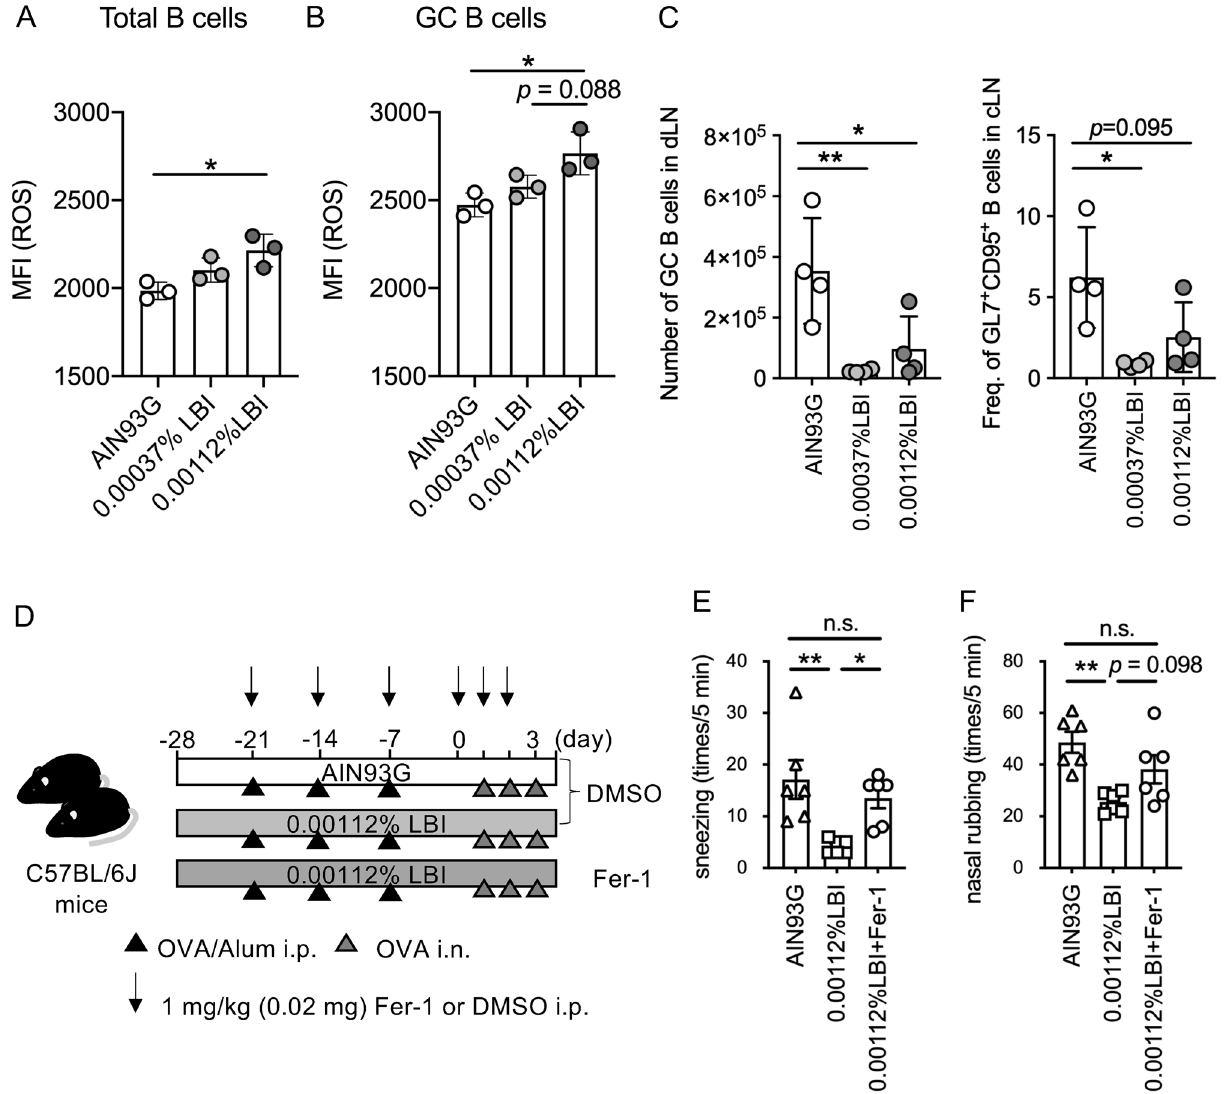
Figure 6. LBI increases the levels of reactive oxygen species ROS in the B cells of draining lymph nodes at a steady state. ( A , B ) Male C57BL/6 J mice were fed AIN93G, 0.00037% LBI, or 0.00112% LBI diets for one week. MFI of ROS in the total ( A ) or GL7 + CD95 + CD45 + B220 + CD3ε - germinal center B cells ( B ) of draining lymph nodes. The representative data of two independent experiments are shown as the means ± SD ( n = 3 for each point). ( C ) Male C57BL/6 J mice were fed AIN93G, 0.0037% LBI, and 0.00112% LBI diets for 3 weeks. The number and frequency of GL7 + CD95 + CD45 + B220 + CD3ε - germinal center B cells in draining lymph nodes. ( D ) A scheme of the experimental protocol of allergic arthritis model. Fer-1 or DMSO was intraperitoneally injected in LBI-fed mice. ( E , F ) Frequency of sneezing ( E ) and nasal rubbing ( F ) were evaluated for 5 min immediately after the administration of intranasal PBS or OVA exposure at day 3. The data were pooled from two different experiments and are shown as the means ± SEM (n = 6 for each group). One-way ANOVA test with Tukey’s multiple comparisons test. n.s.: not significant, * p < 0.05, ** p < 0.01. MFI, mean fluorescence intensity; ROS, reactive oxygen